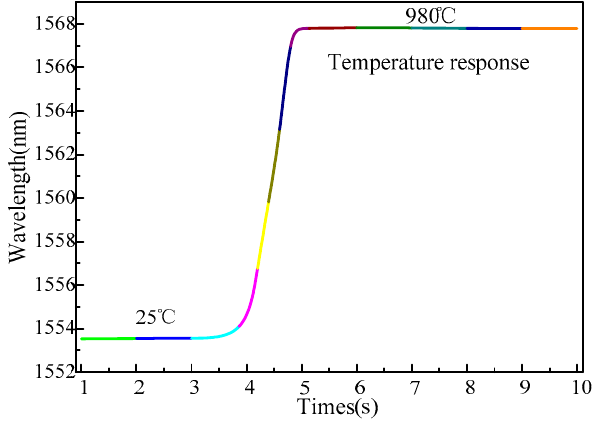
Figure 10. Temperature response time.